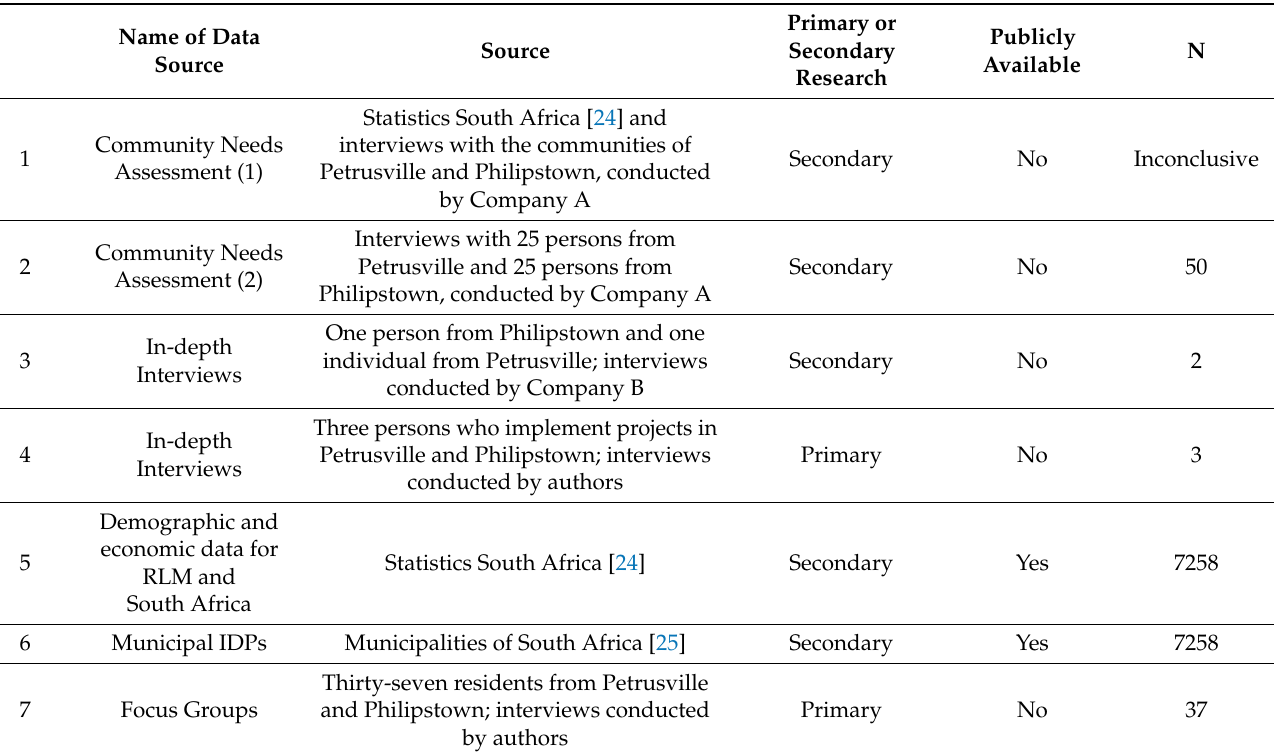
Table 1. Summary of data